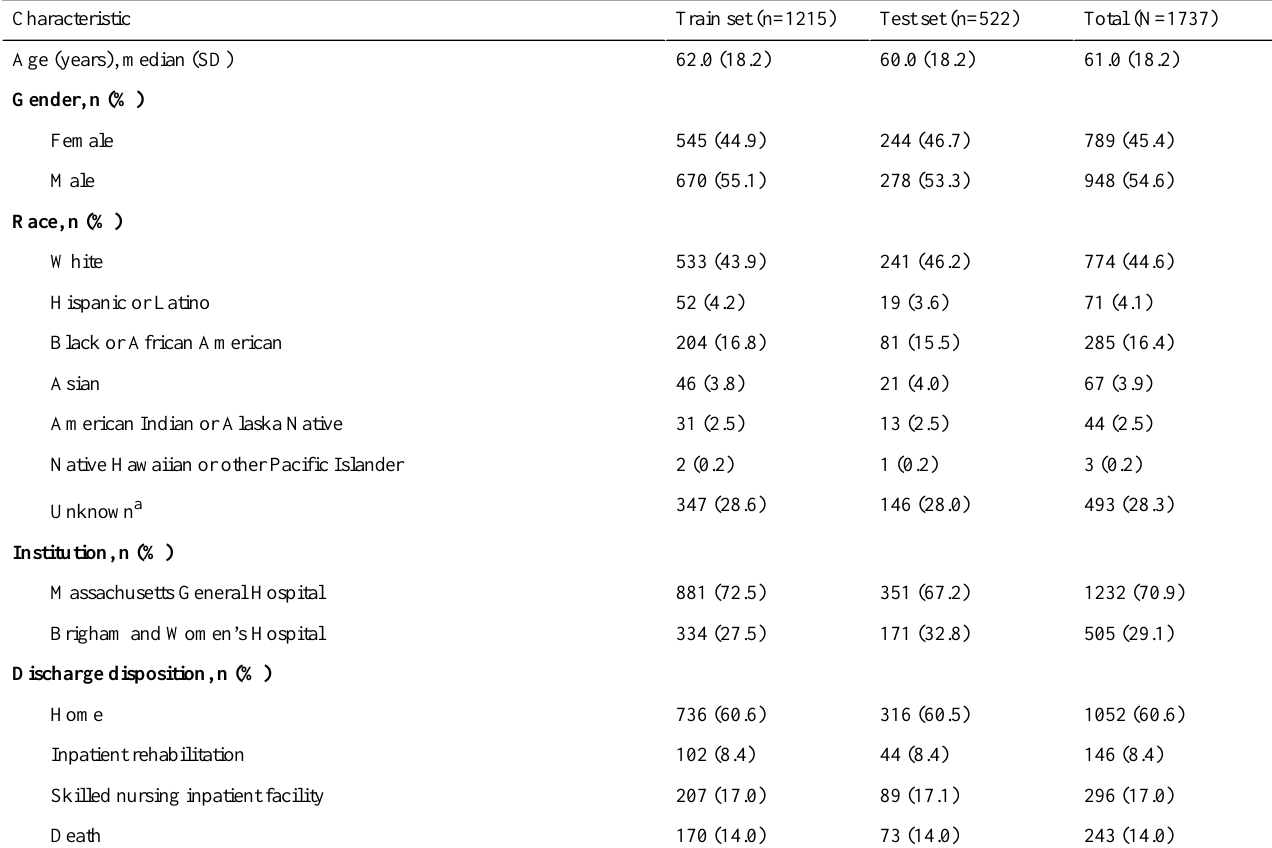
Table 2. Baseline characteristics of the study patient population stratified by train and test